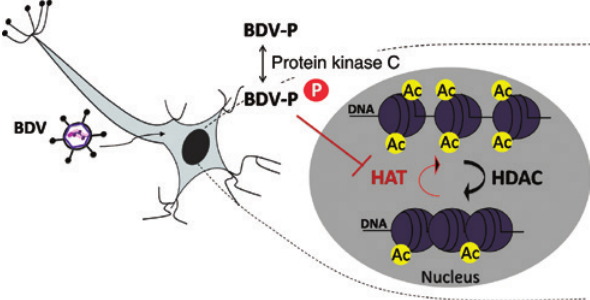
Figure 3: Model of Bornavirus interference with histone acetylation in infected